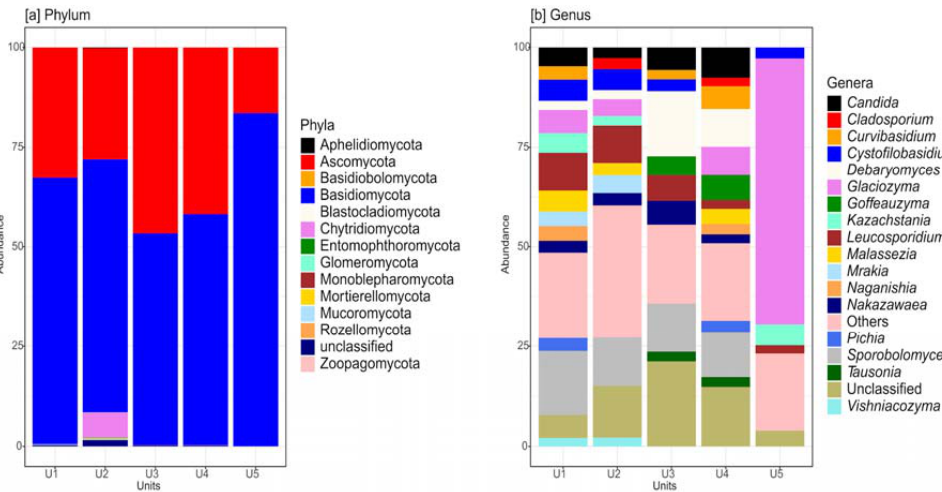
Figure 2. Fungal diversity (considering filamentous fungi, yeasts, and unclassified taxa) found in the five units of the permafrost core of Adelie Cove rock glacier (U1, U2, U3, U4, and U5). Relative abundance of ASVs distribution at phylum level ( a ); relative abundance of ASVs distribution at genus level ( b ).